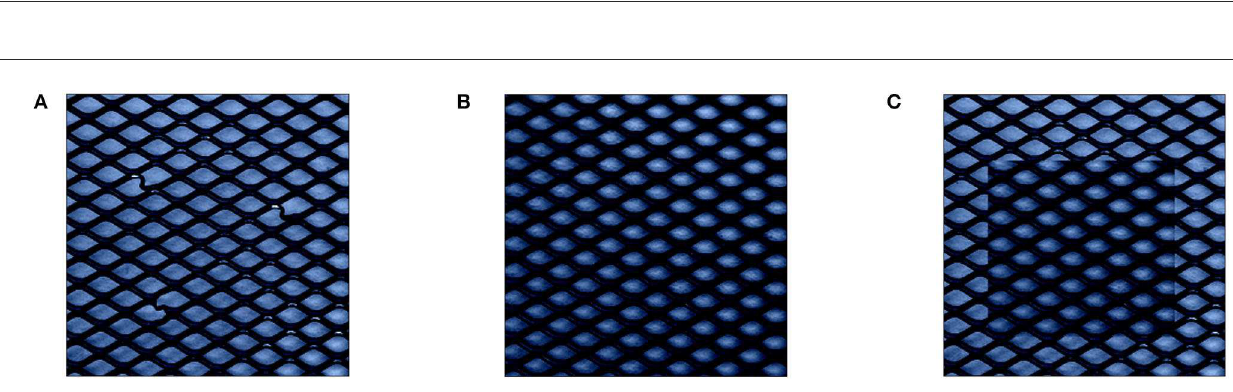
FIGURE3 Demonstration of perturbation with nearest neighbor in normal train data as reference r : [ (A) Anomalous MVTec image x , (B) nearest neighbor as r , and (C) x ′ with nearest neighbor as r .] While r is visually closer to the anomaly x than the mean of training data from Figure 2E, the perturbed point x ′ still shows highly anomalous characteristics on the replacement